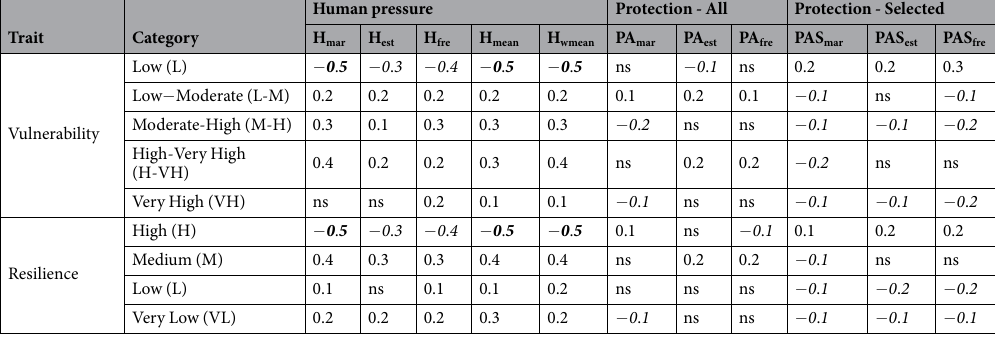
Table 4. Pairwise Pearson correlation between traits of the fish assemblages (relative taxa richness of trait categories) in a set of estuaries distributed worldwide with: intensity of human pressure (H), percentage of coverage by protected areas (PA) and percentage of coverage by selected areas of IUCN management categories I-IV (PAS). Each variable for human pressure and protection was estimated for marine (mar), estuarine (est) and freshwater ecosystems (fre); and mean and weighted mean (wmean) of human pressure are also included. All variables (except fish traits) were log transformed and in addition pressure variables were normalized (scaled to vary between 0 and 1). ns - not significant at p < 0.05. (Total number of samples is 530, for a total of 378 estuaries). Correlations below 0 are in italic, and correlations above 0.5 or below − 0.5 are in bold